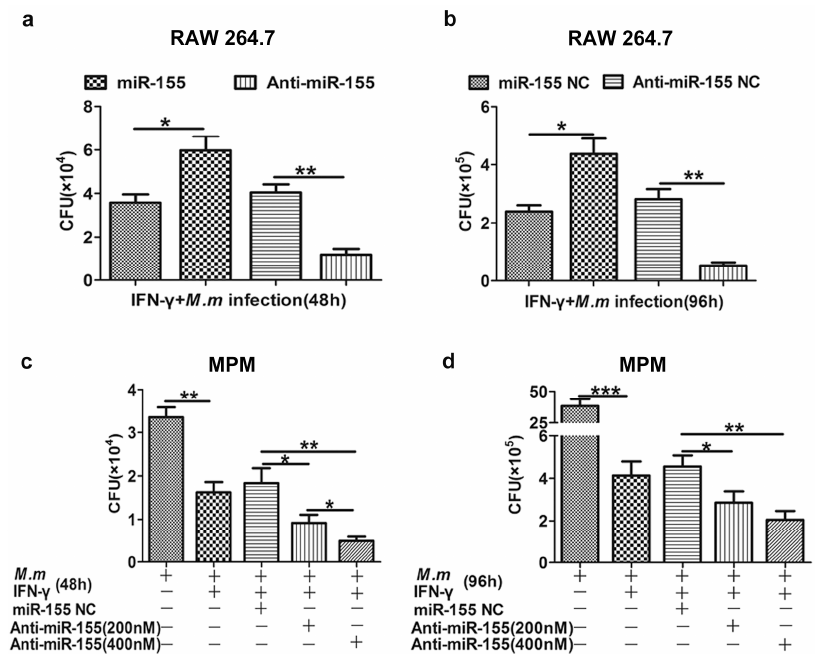
Figure 2. miR-155 negatively regulates the antimycobacterial activity of IFN- γ activated macrophages. RAW 264.7 cells ( a , b ) and MPM ( c , d ) were transfected with miR-155 NC, miR-155 or anti-miR-155 NC, anti-miR-155 prior to infection with IFN- γ / M.m for 48 and 96 h, and intracellular M.m survival was quantified by Colony Forming Unit (CFU) assays at the indicated time points. All data represent the mean ± SEM from three independent experiments, * p < 0.05, ** p < 0.01, *** p < 0.001.